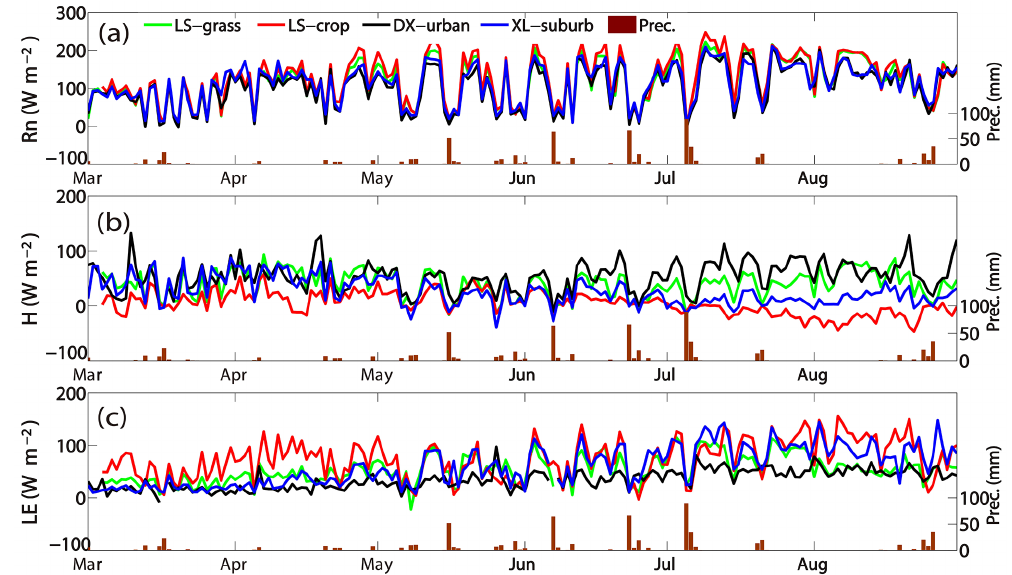
Figure 7. Daily variations in (a) net radiation, (b) sensible heat flux, and (c) latent heat flux at the four sites in Nanjing from March to August